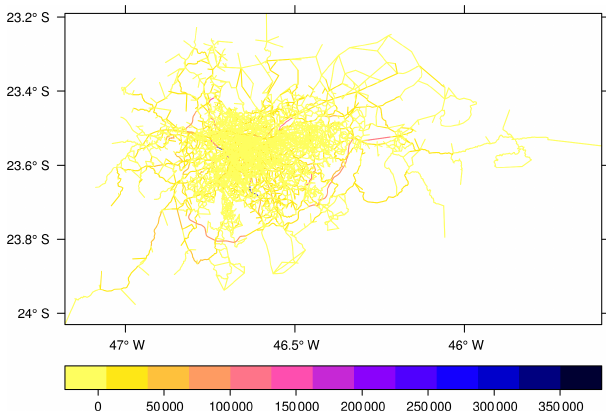
Figure 7. CO emissions (colored lines; gh − 1 ) for LDV on Friday 19:00LT over